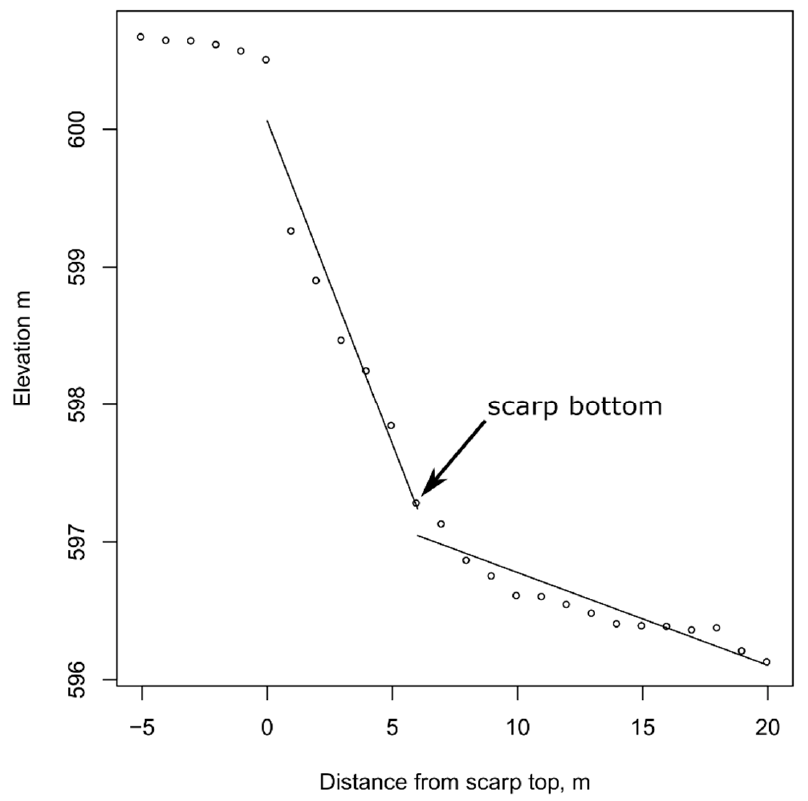
Figure 3. Extraction of scarp height from a Digital Elevation Model (DEM). Elevations were extracted at 1-m intervals from a DEM along the slump centerline. The top of the scarp was located from the manually digitized slump perimeter. The bottom of the scarp was located by sequentially selecting trial breakpoints and fitting linear regressions to the elevations above and below. The breakpoint (labeled “scarp bottom”) resulting in the lowest combined mean square deviation for the two lines was accepted as the bottom of the scarp (data from slump NOAT070 in 2013).